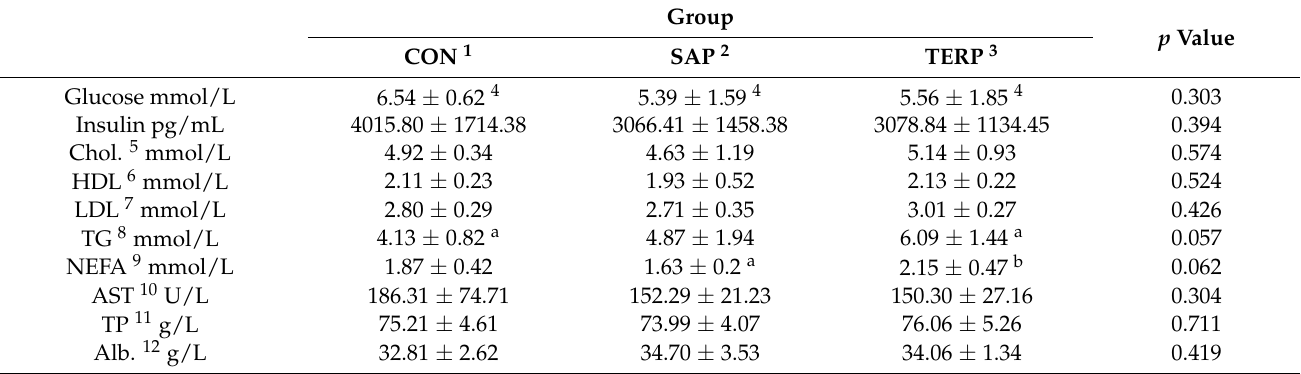
Table 6. Mean values of lipid and biochemical parameters and activity of AST in blood Zucker rats.